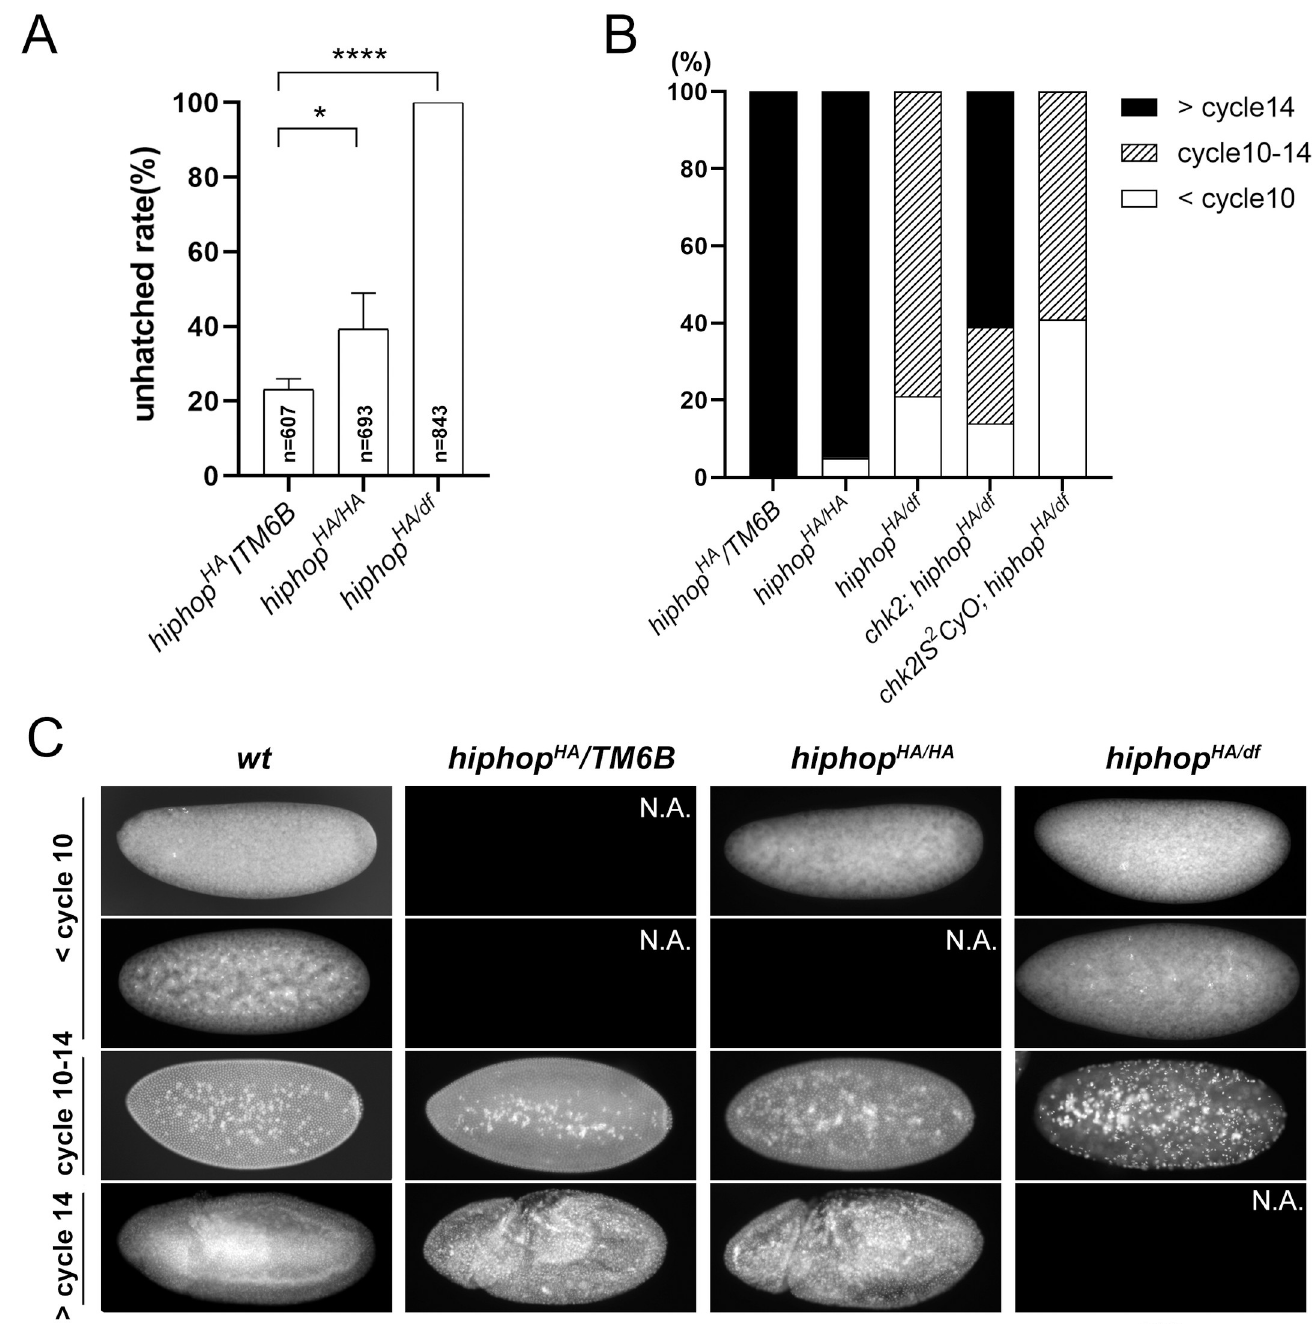
Fig 4. hiphop HA causes maternal effect embryonic lethality. A . Hatching rates of embryos from hiphop mutant females and their heterozygous siblings. For each genotype, at least 30 females were tested. B . Quantifications of developmental arrest of hiphop -mutant embryos. Fixed embryos were scored for their approximate stage of development based on DAPI staining. For each genotype, at least 210 embryos were examined. C . Representative images of DAPI-stained embryos at various early stages. Developmental stages are indicated to the left, maternal genotypes at the top with w 1118 used as wt . N.A.: not available, embryos at the indicated stage were not